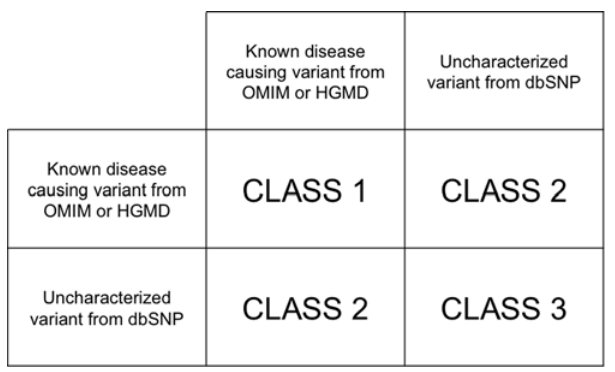
Figure 2. Classification system for variant pairs.